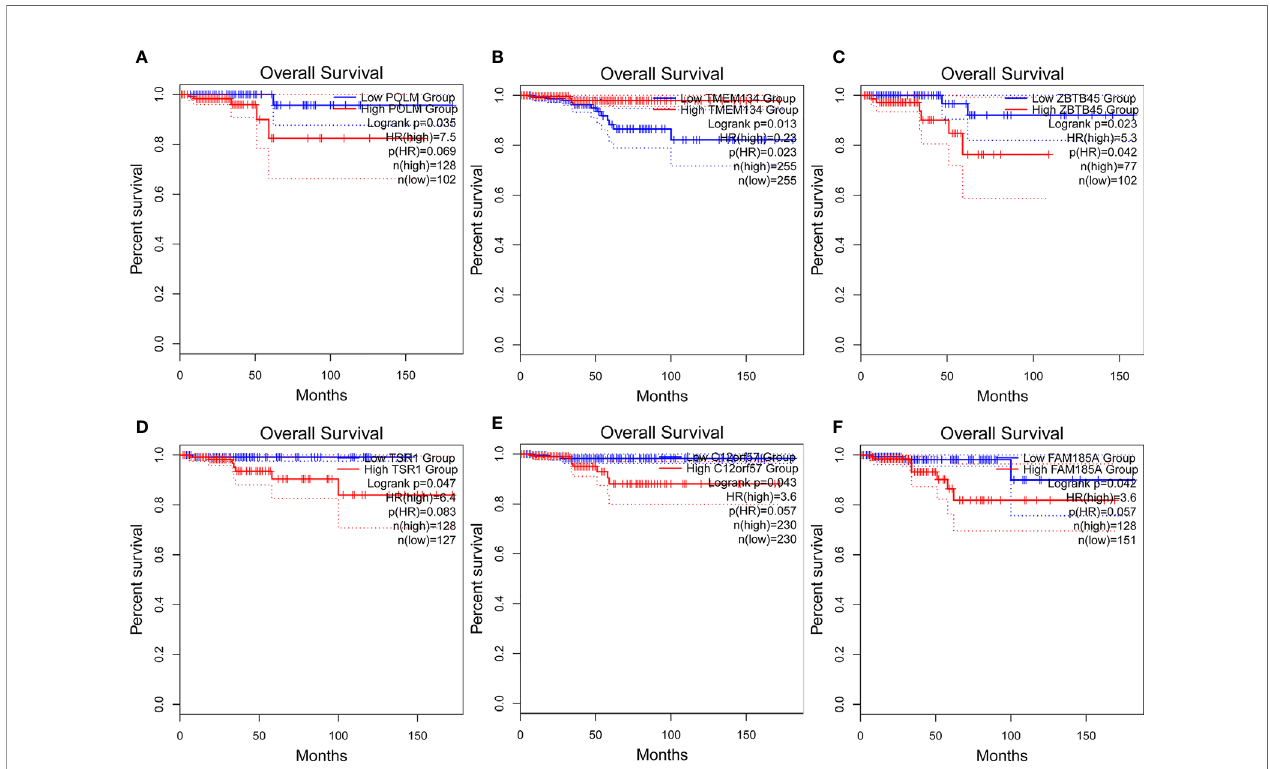
FIGURE 7 | Survival analysis of AS parent genes in the fi nal prediction model. Kaplan – Meier analyses of (A) POLM, (B) TMEM134, (C) ZBTB45, (D) TSR1, (E) C12orf57, (F) FAM185A. The statistical signi fi cance was determined by log-rank